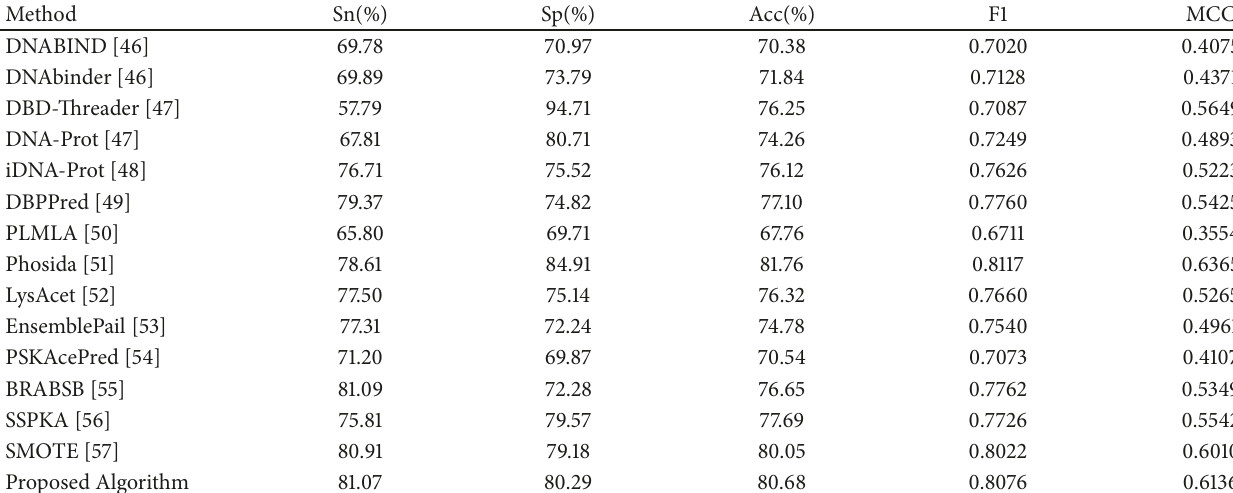
Table 2: The Performances of Different